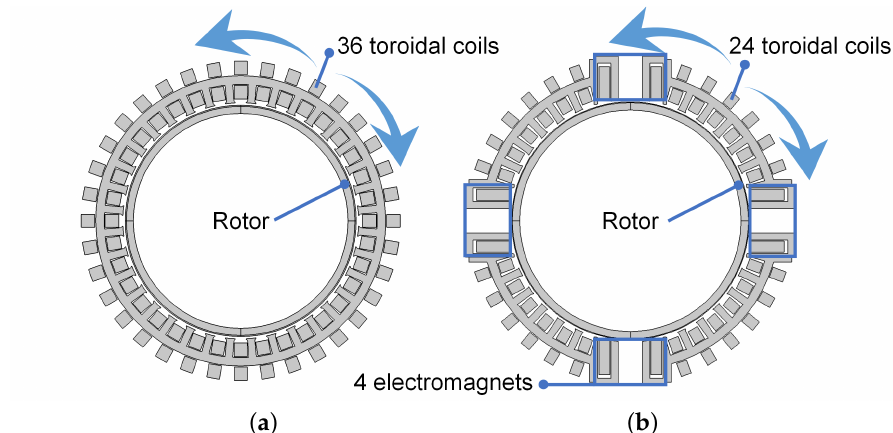
Figure 4. Section diagram of the reaction sphere (one-DOF): ( a ) 36 toroidal coils. ( b ) 24 toroidal coils and 4 electromagnet